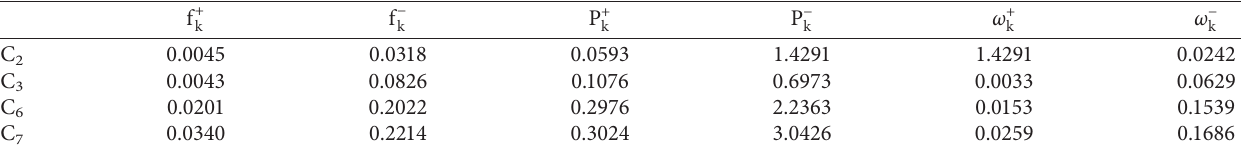
Figure 3: The density map and nucleophilicity index of β -himachalene. Table 2: Local reactivity properties of reagents calculated using the DFT method for NPA-derived